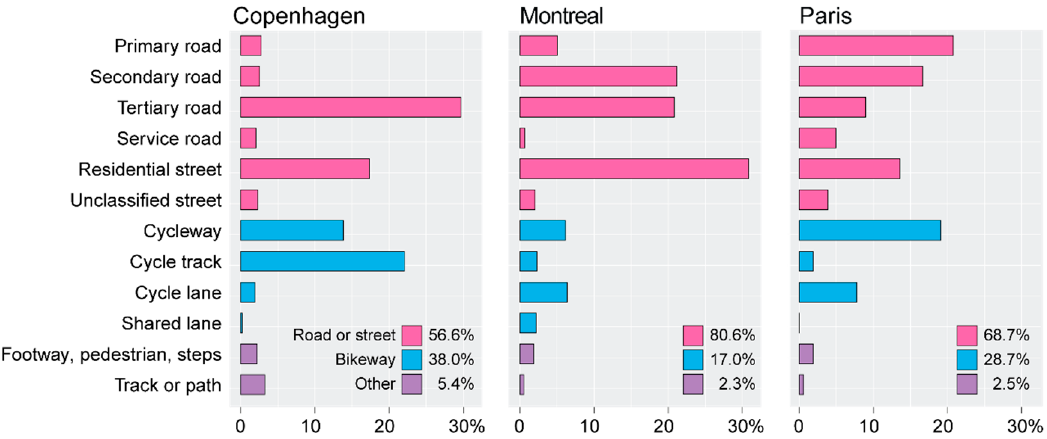
Figure 2. Time spent on each type of road or bicycle infrastructure.